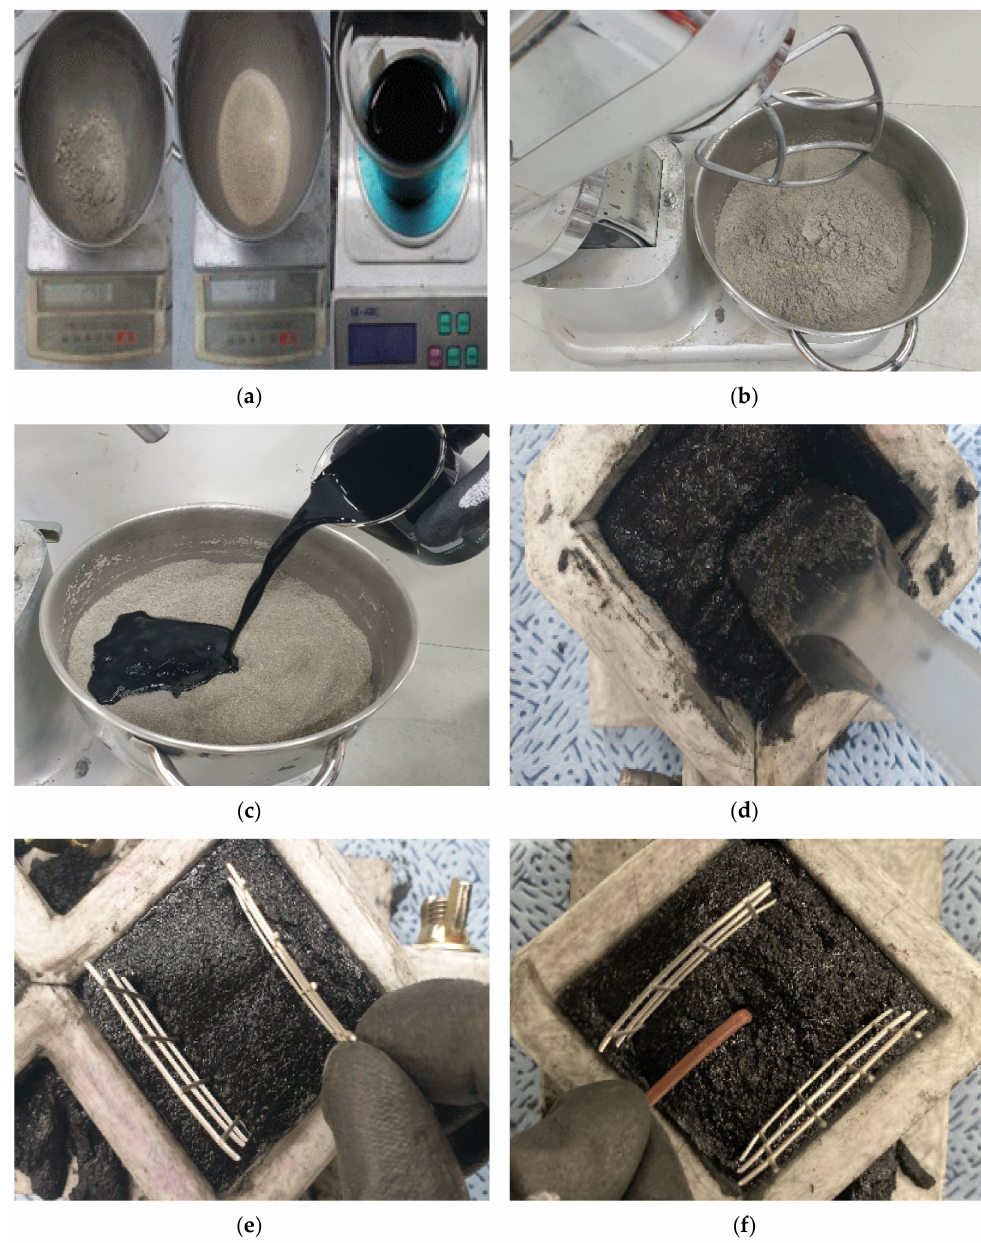
Figure 2. Fabrication processes associated with the tested specimens. ( a) Measuring materials; ( b ) Dry mixing (2 min); ( c ) Nanosolution mixing (3 min); ( d ) Compaction; ( e ) Insert stainless steel mesh; ( f ) Insert